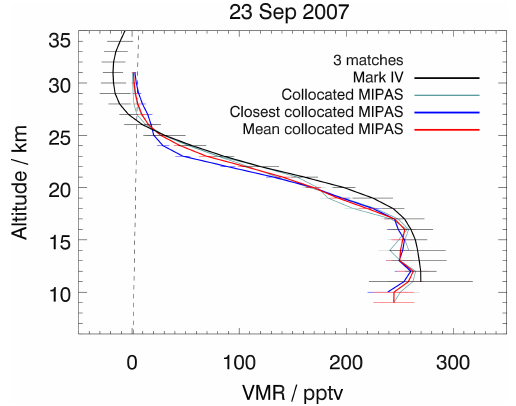
Figure 3. Comparison of one MkIV CFC-11 profile (black line) with three coincident profiles of MIPAS (blue-grayish lines). The closest (blue line) and the mean (red line) of these profiles are shown in addition. The MkIV error estimates are inferred from the fit resid- uals.